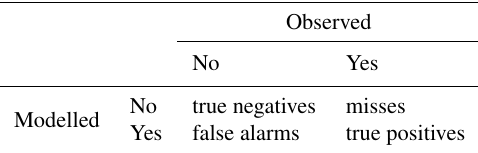
Table A1. Explanation of a contingency table of the confusion ma- trix for the final model performance fit; see Fig.